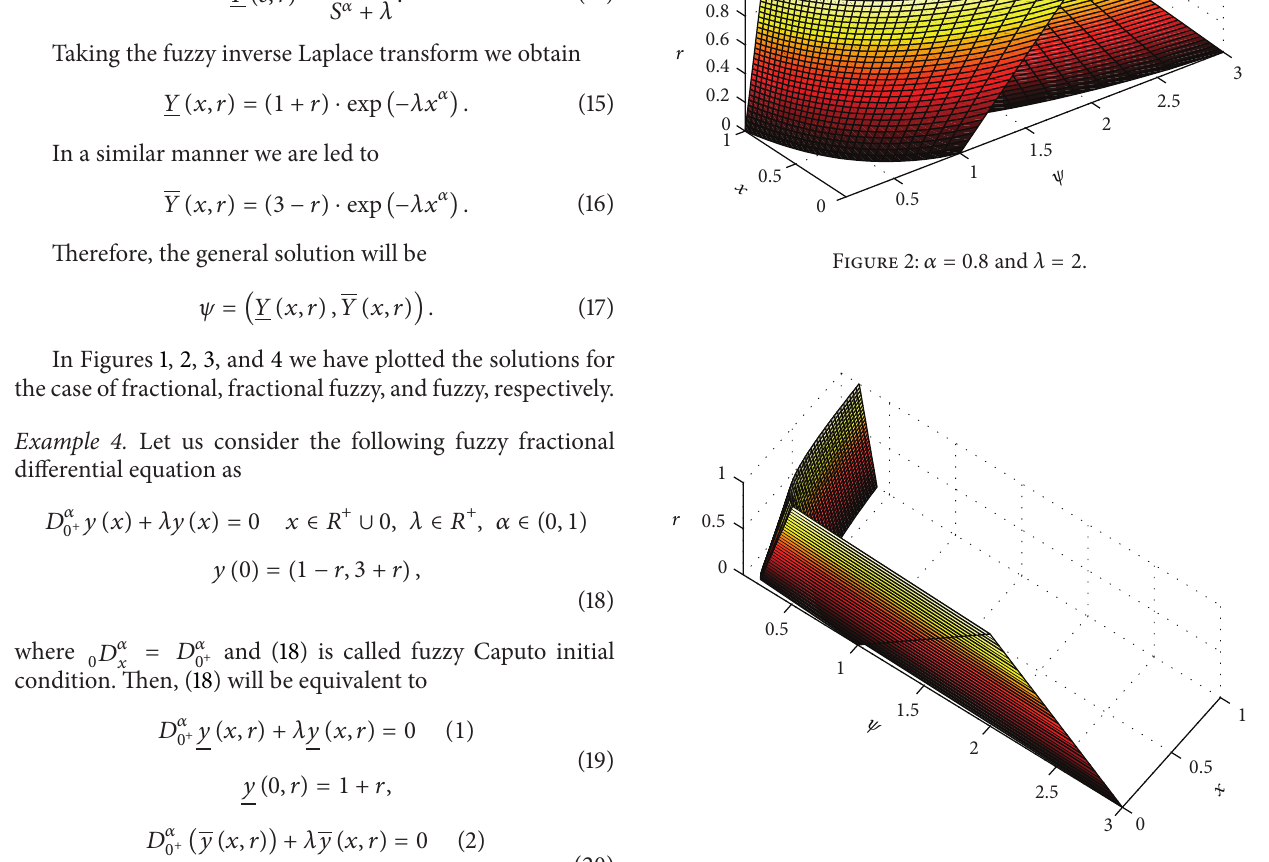
Figure 3: 𝛼 = 0.1 and 𝜆 = 2